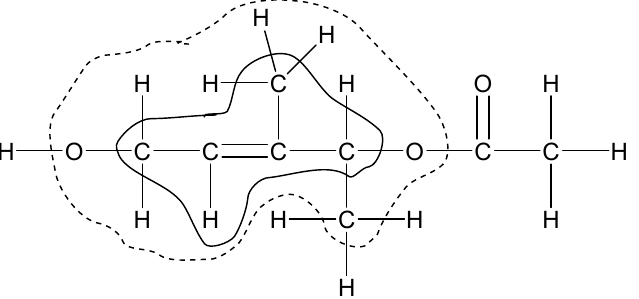
Figure 1. Thermochemical groups with a central “complex atom” C=C used in homodesmotic reactions of first level ([C=C-(C)(H);(C) 2 ], inner area) and second level ([C=C-(C-(H) 2 (O))(H);(C-(H) 3 )(C-(C)(H)(O))], dotted outer area).